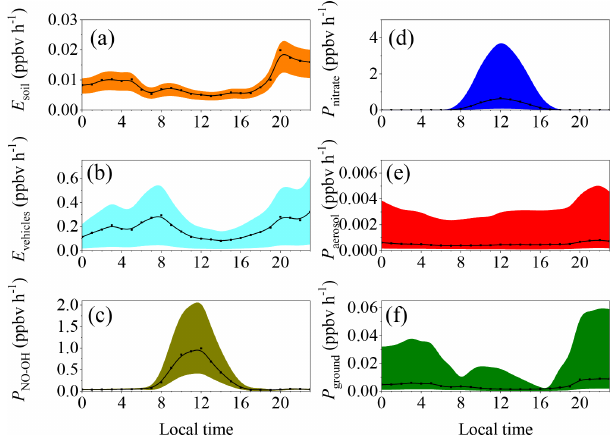
Figure 3. Diurnal pattern of the HONO sources calculated using different parameterizations. The lower bound, the middle value, and the upper bound of (a) the soil emissions calculated based on wa- ter contents of 45%–55%, 35%–45%, and 25%–35%; (b) ve- hicle emissions with emission factors relative to NO x of 0.18%, 1.17 ± 0.05%, and 1.8%; and (c) the production from the reaction between NO and OH, the concentrations of which were estimated using the methods of Xu et al. (2015) and Tan et al.